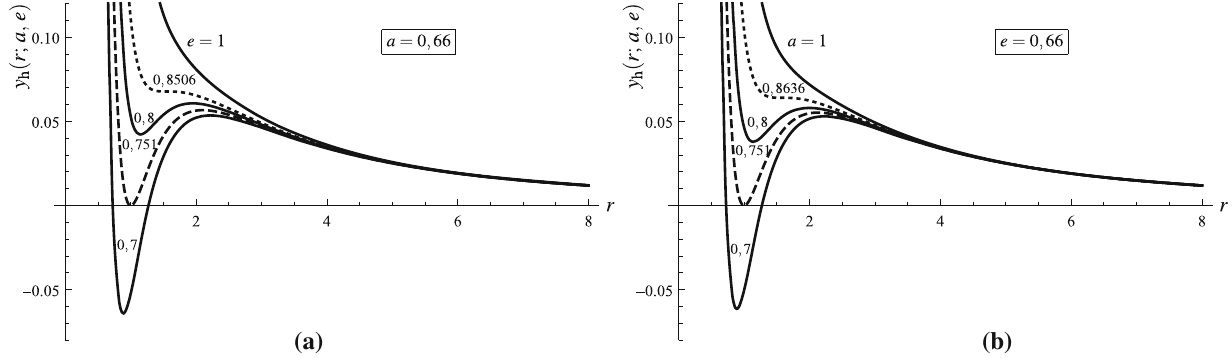
correspond to the case where a 2 + e 2 = 1, dotted profiles correspond to situation in which both local extrema coincide in an inflex